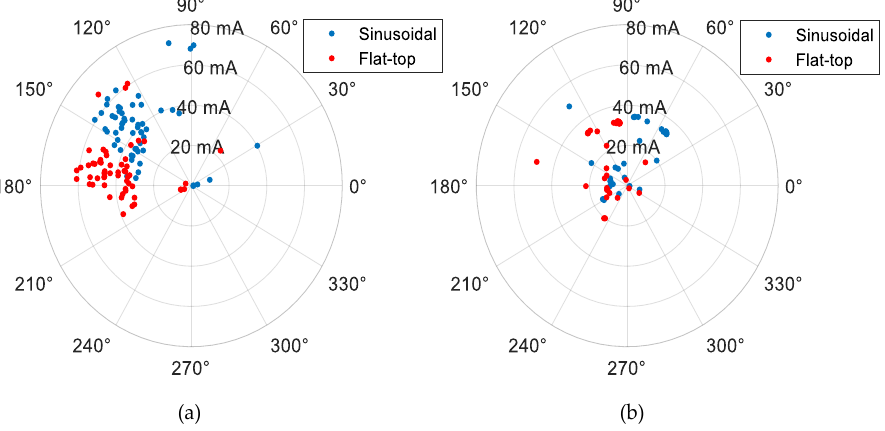
Figure A3. Fifth harmonic current emission of the selected lamps under the two types of supply voltage: ( a ) CFL and ( b ) LED lamps.